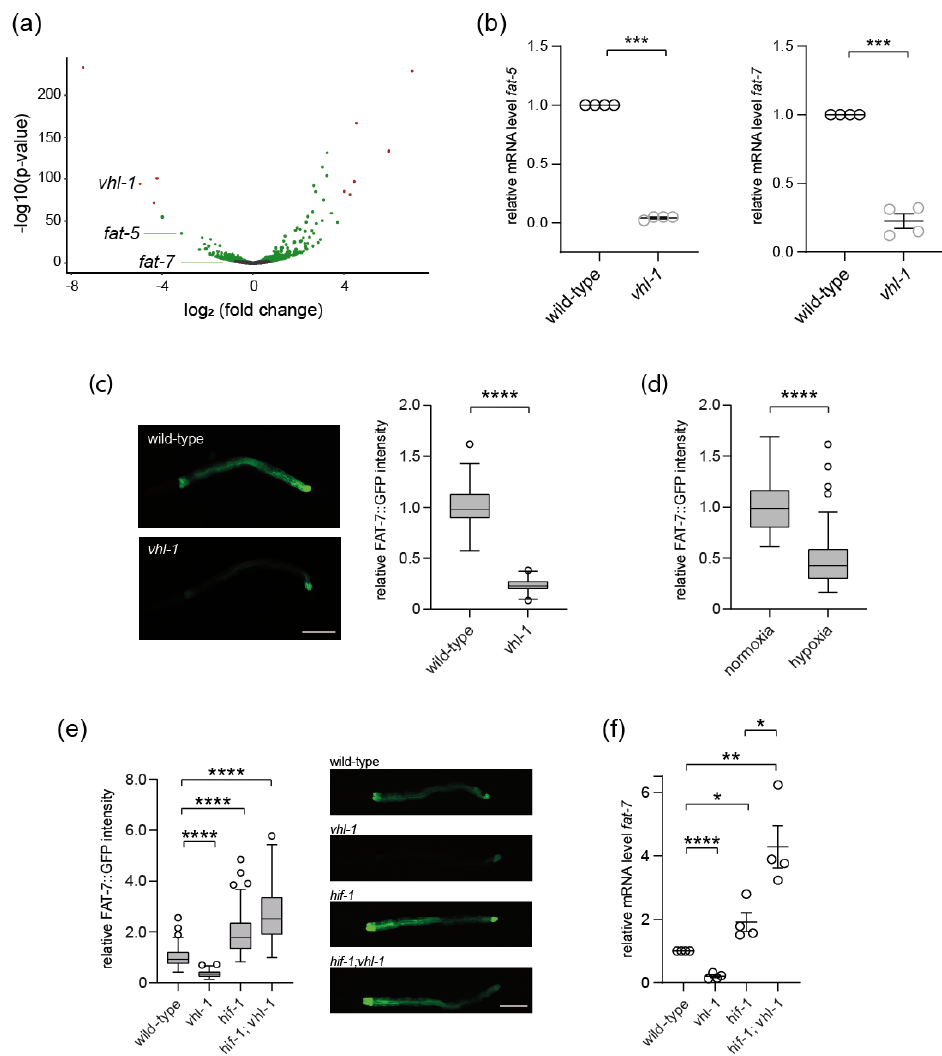
Figure 3. fat-7 /SCD5 is downregulated in C. elegans vhl-1 mutants. ( a ) Volcano plot showing differentially expressed genes between vhl-1 mutants and wild-type. ( b ) fat-5 and fat-7 expression is downregulated in vhl-1 mutants. fat-5 and fat-7 mRNA expression in wild-type animals and vhl- 1(ok161) mutants was analyzed by RT-qPCR. Data are mean ± SEM of four independent experiments. t -test. *** p < 0.001. ( c ) vhl-1 mutants show reduced FAT-7::GFP expression. Representative fluorescence images of otherwise wild-type and vhl-1(ok161) animals expressing a fat-7 ::GFP translational reporter (nIs590). Scale bar indicates 100 µ m. Right panel shows quantification of FAT-7::GFP in wild-type and vhl-1 mutants. Three independent experiments were performed. n > 50 for each condition. Mean ± SEM. **** p < 0.0001 ( t -test). ( d ) Effect of hypoxia on FAT-7::GFP expression. Wild-type animals expressing FAT-7::GFP were exposed to low oxygen (0.5% in a hypoxia chamber) and compared to controls grown under standard conditions (21% oxygen). Quantification of FAT-7::GFP expression. n > 50 for each condition. Mean ± SEM. **** p < 0.0001 ( t -test). ( e ) VHL-1 and HIF-1 antagonistically regulate fat-7 expression. Fluorescence micrographs of wild-type, hif-1(ia04) , vhl-1(ok161) , and hif- 1;vhl-1 mutants showing expression of FAT-7::GFP. Scale bar indicates 100 µ m. Left panel shows quantification of FAT-7::GFP fluorescence intensity. Three independent experiments, n > 50 for each genotype. Mean ± SEM. **** p < 0.0001 (ANOVA). ( f ) Inactivation of hif-1 abrogates downregulation of fat-7 expression in vhl-1 mutants. RT-qPCR results showing fat-7 mRNA levels in wild-type, vhl-1(ok161) , hif-1(i104) , and hif-1;vhl-1 mutants. * p < 0.05, ** p < 0.01, **** p < 0.0001 ( n = four for each